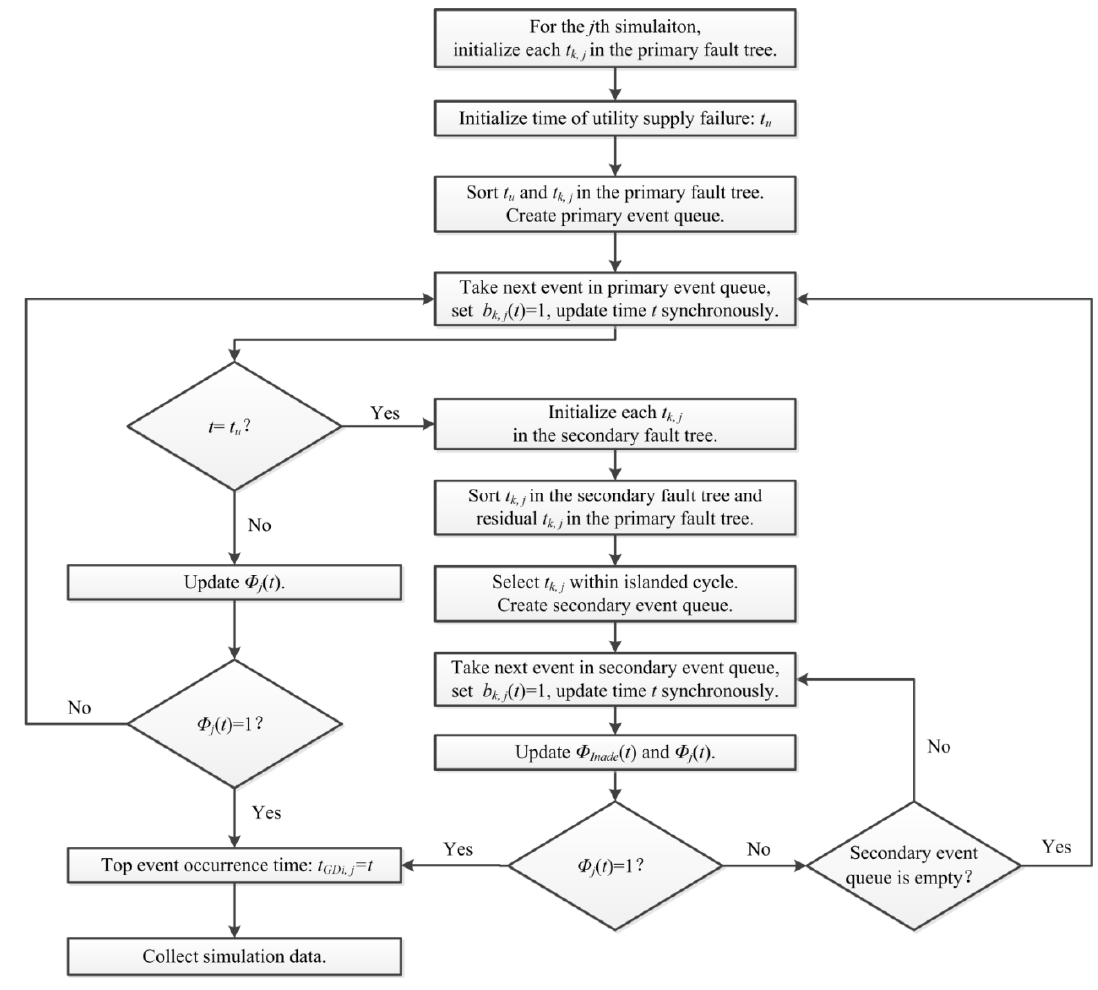
Figure 5. Flow chart of procedure for a single time of